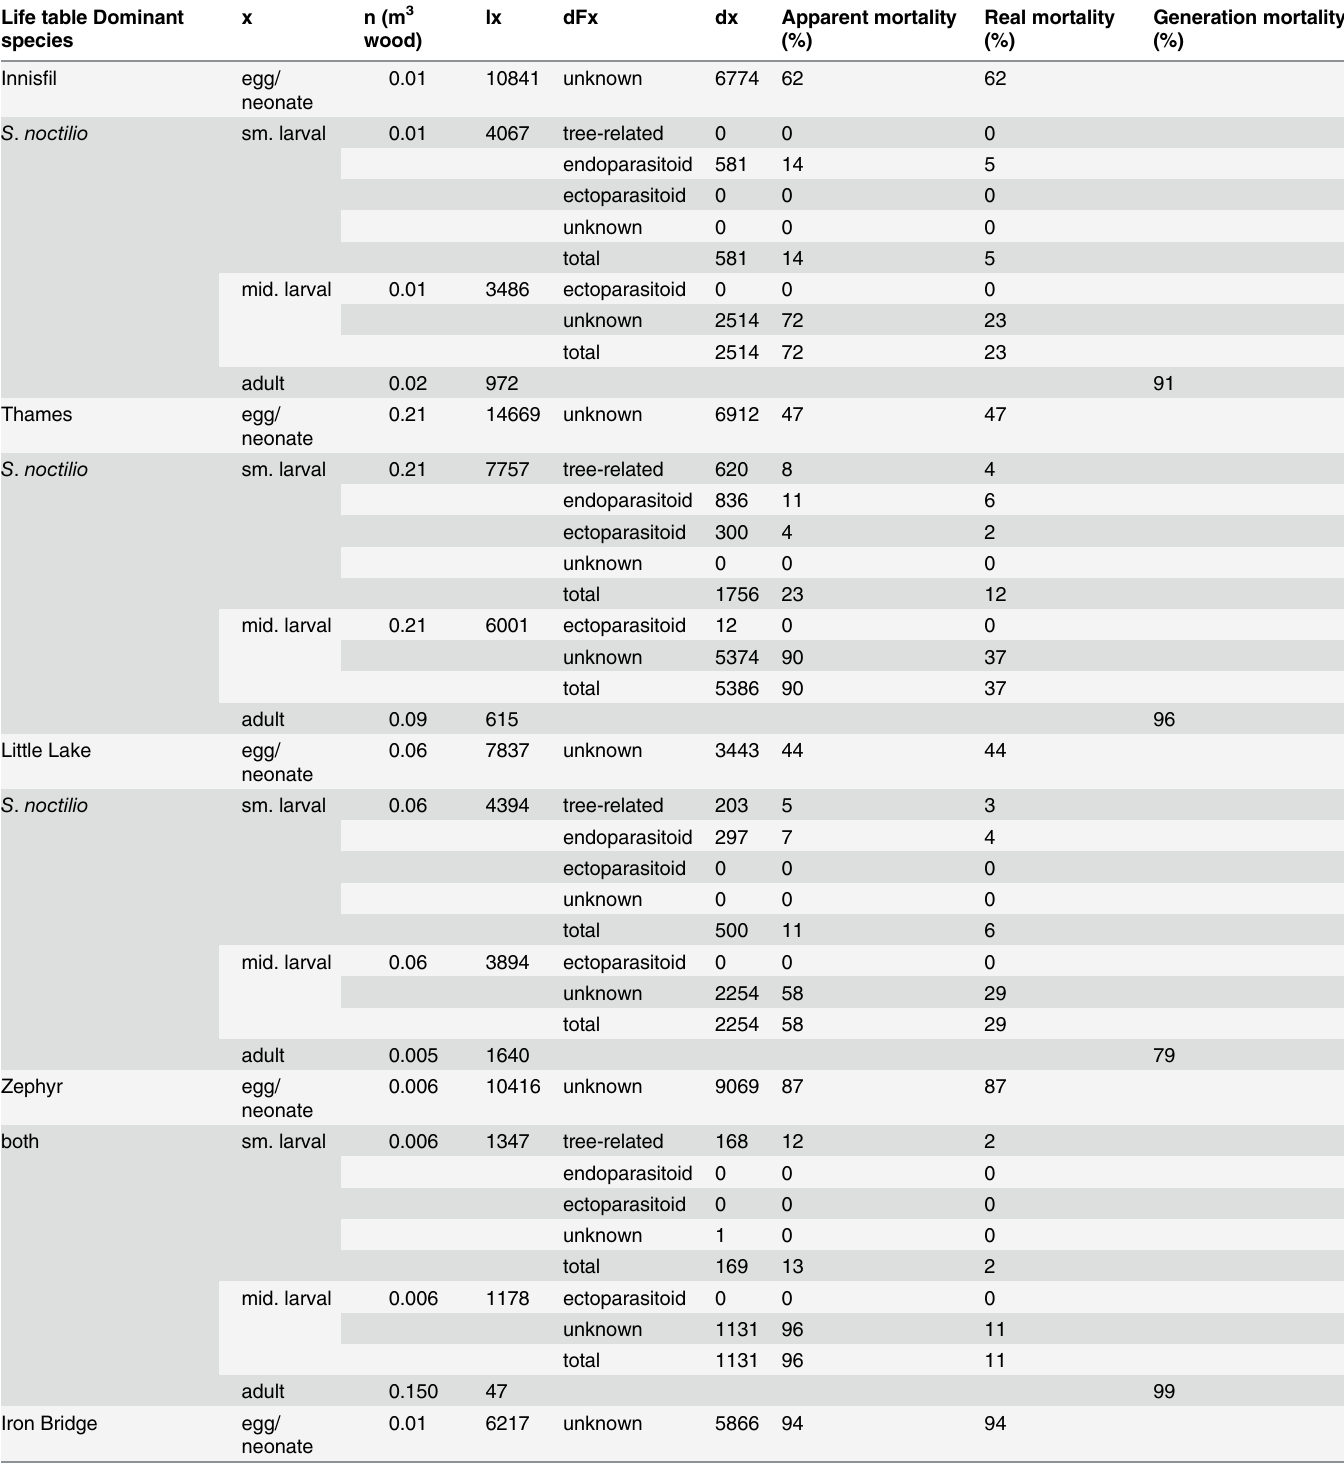
Table 4. Partial age-specific life tables (2013 – 2014), including mortality factors, from the natural Sirex population at six sites throughout Ontario. Life table Dominant